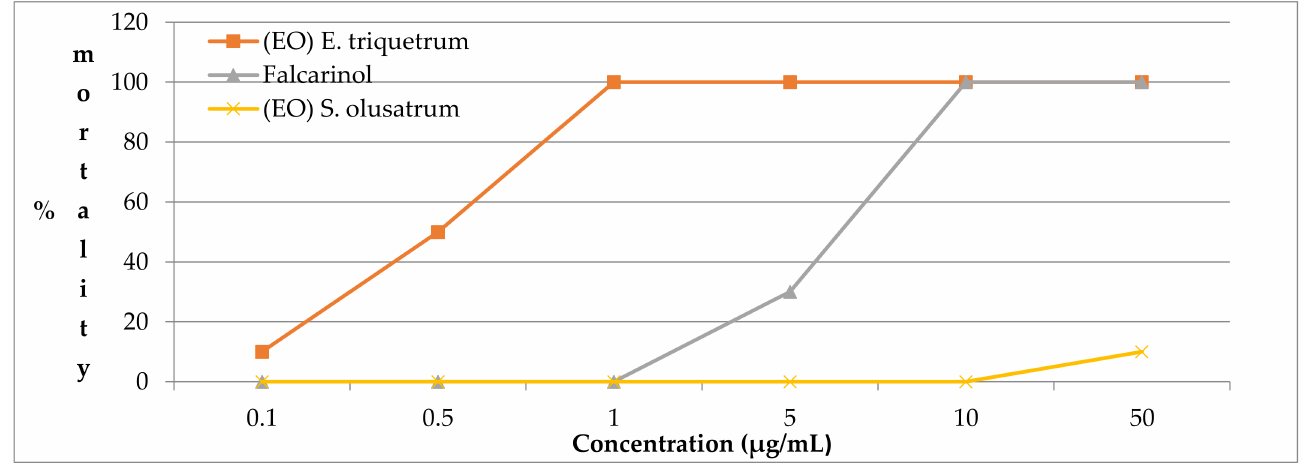
Figure 4. The death rate of B. glabrata at different concentrations of essential oils E. triquetrum and S. olusatrum and major compounds.